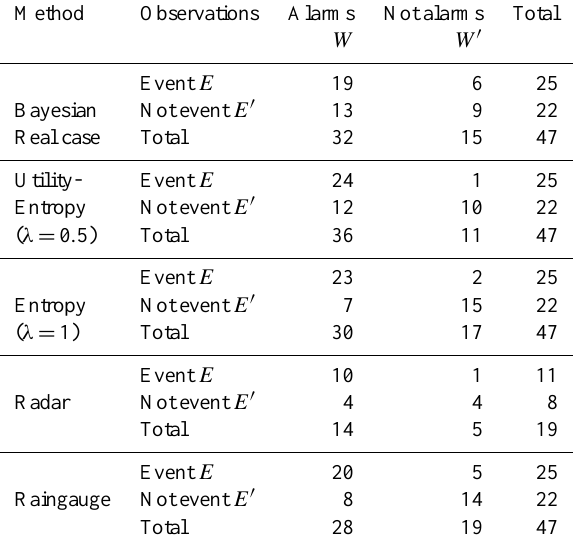
Table 5. Two-by-two contingency table for assessing the efficiency of rainfall threshold evaluation